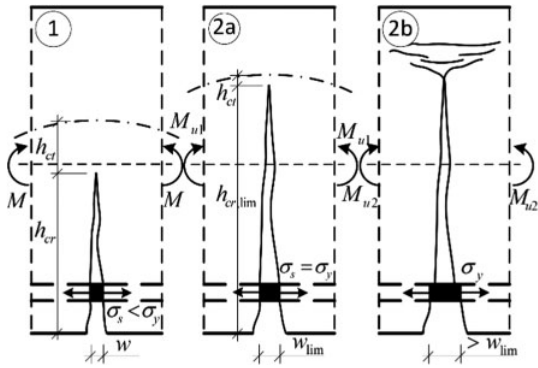
Fig. 5. Stages of development of a normal crack